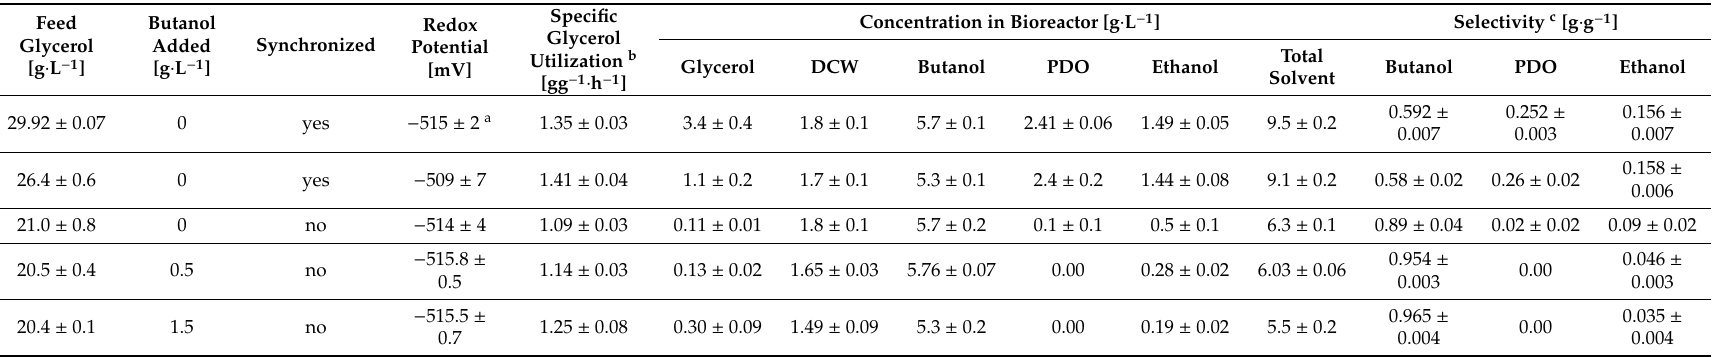
Table 1. Summary of average data for the investigation of feed glycerol concentration and supplemental butanol on self-synchronized oscillatory metabolism. Feed